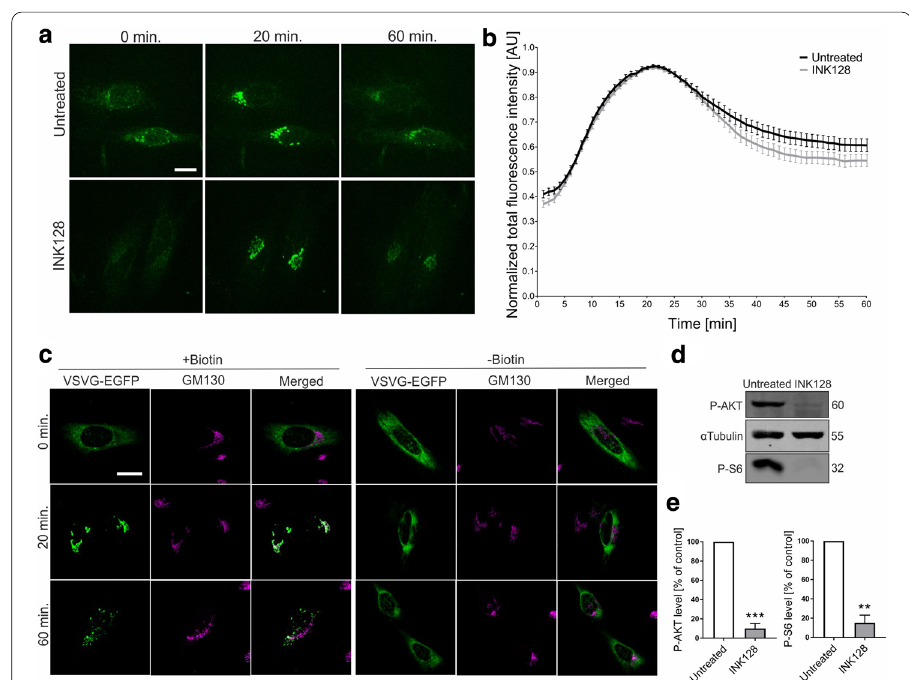
Fig. 1 Inhibition of mTOR does not influence ER-to-GA VSVg trafficking in early-passage HeLa cells. a Representative time-lapse confocal images of living HeLa cells that were transfected with Str-li_ VSVGwt-SBP-EGFP and treated with INK128 (300 nM, 30 min) or untreated (control). Trafficking of VSVg-EGFP was visualized using the RUSH assay for 60 min after the addition of biotin (time 0). Scale bar 20 µm. b = Quantitative analysis of experiments performed as in ( a ). The graph depicts VSVg-EGFP fluorescence intensity in the Golgi apparatus region at each time point, normalized to the maximum value. The data are expressed as the mean for all of the analyzed cells. Error bars indicate SEM. N 4 independent experiments. Number = of cells per variant ( n ): Untreated (35), INK128 (45). c Representative confocal images of HeLa cells that were transfected with Str-li_VSVGwt-SBP-EGFP (green) and immunofluorescently stained for the cis -Golgi marker GM130 (magenta). Scale bar 20 µm. d Western blot analysis of phospho-AKT (P-AKT) and phospho-S6 = (P-S6) levels in protein lysates from control HeLa cells or cells after INK128 treatment (300 nM, 30 min). e Quantification of Western blot analysis of P-AKT and P-S6, normalized to tubulin, in protein lysates that were obtained from HeLa cells that were treated as in ( d ). ** p < 0.01, *** p < 0.001 (one-sample t -test). N 4 = independent